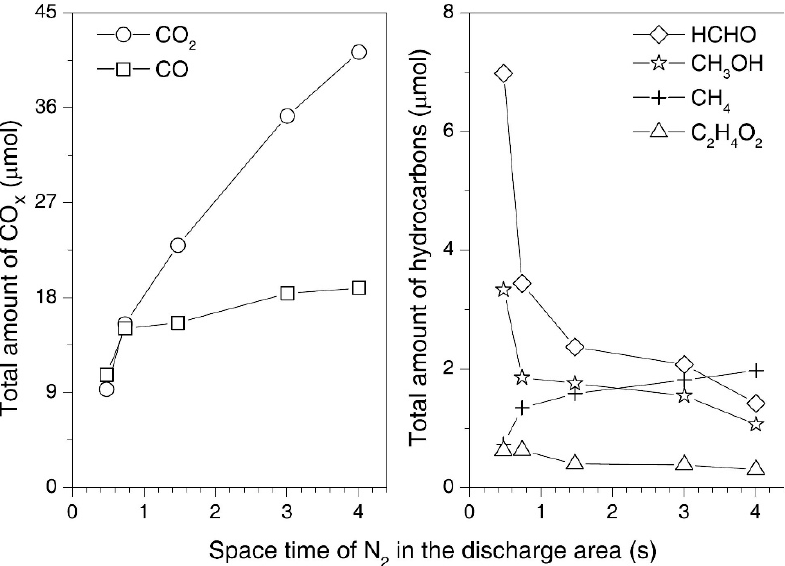
Figure 7. Influence of flow rate on the decomposition of formaldehyde (HCHO) adsorbed on MP 5 (adsorption: 176 mL/min flow rate of polluted N 2 with 99 ppm of HCHO, adsorption time t 1 = 250 min, total amount of adsorbed HCHO: 155 µmol; discharge carrier gas N 2 , discharge power P = 2.2 W). Reprinted from Ref. [48], with permission from